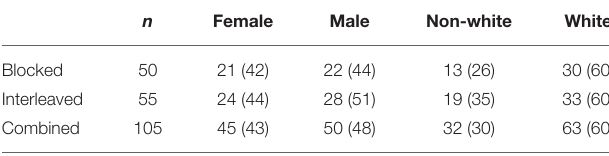
TABLE 1 | Sample sizes and demographic counts (and percentages) by